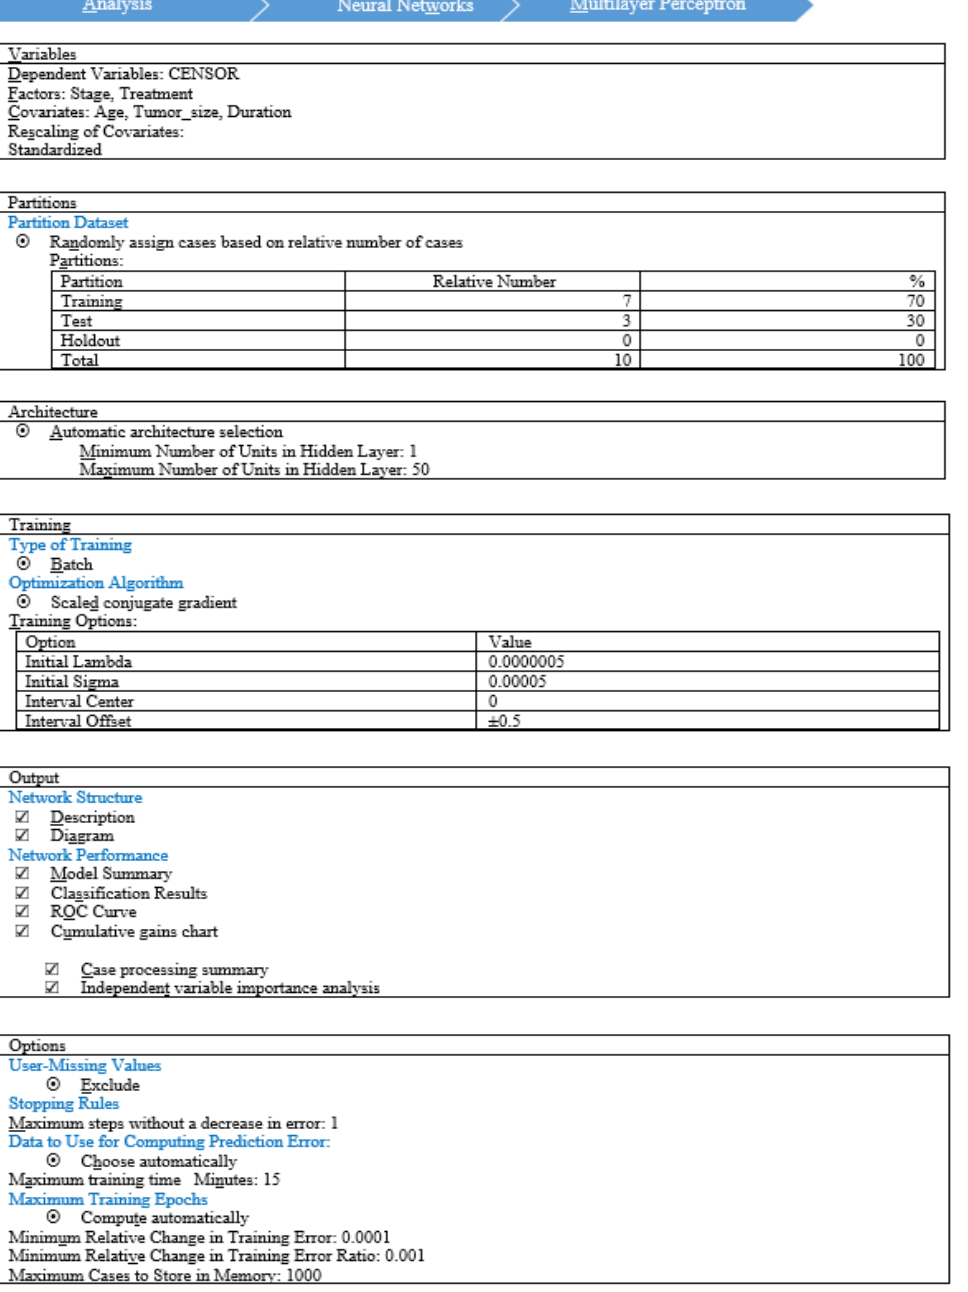
Figure 11. SPSS set up for Artificial Neural